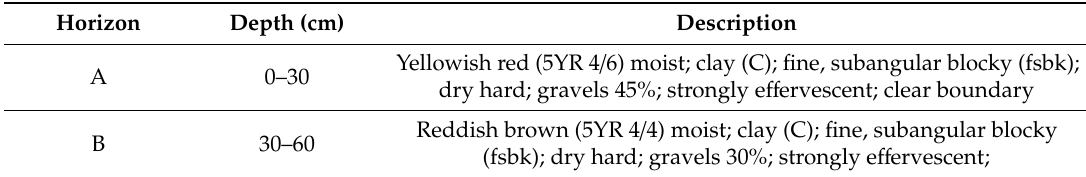
Table A20. Profile P1 horizons description.